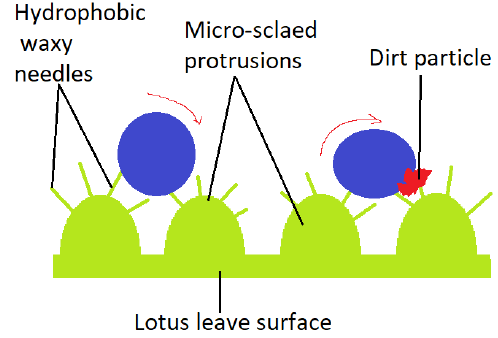
Figure 2. Dirt particle removed by rain drops from the Lotus leave’s surface.